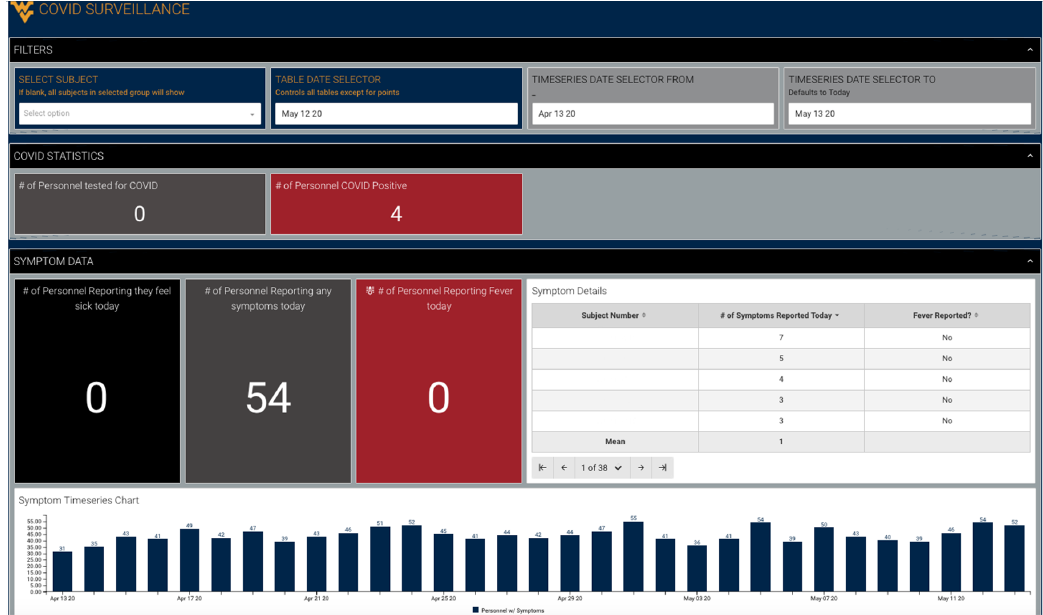
Figure 5. COVID-19 Symptom-Tracking Dashboard.